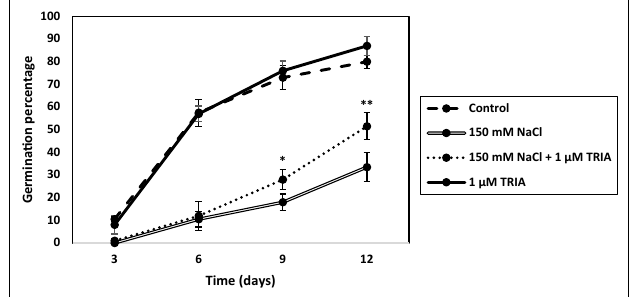
Fig. 1: Effects of NaCl and/or triacontanol (TRIA) on germination of spinach seeds. Significant differences between salt-stressed seeds with and without TRIA treatment are marked with * (P<0.05) and **( P<0.01). Vertical bars represent ± standard error from means (n=4)